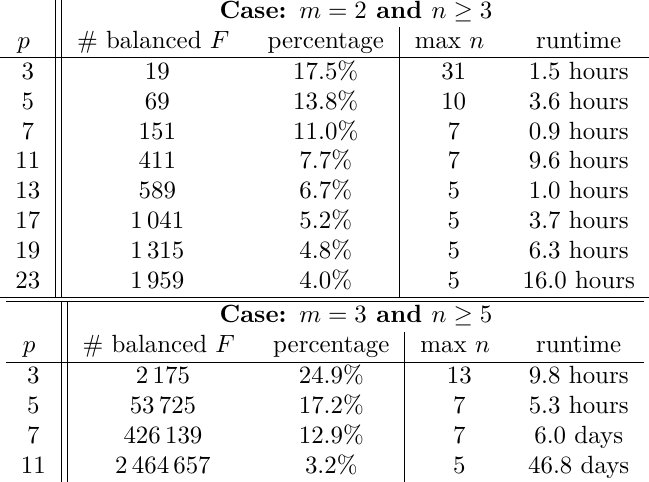
= 0, α 0 , 1 } ) and the 0 , 0 , 0 2 , 0 , 0 , α 0 , 0 , 1 ∈ {